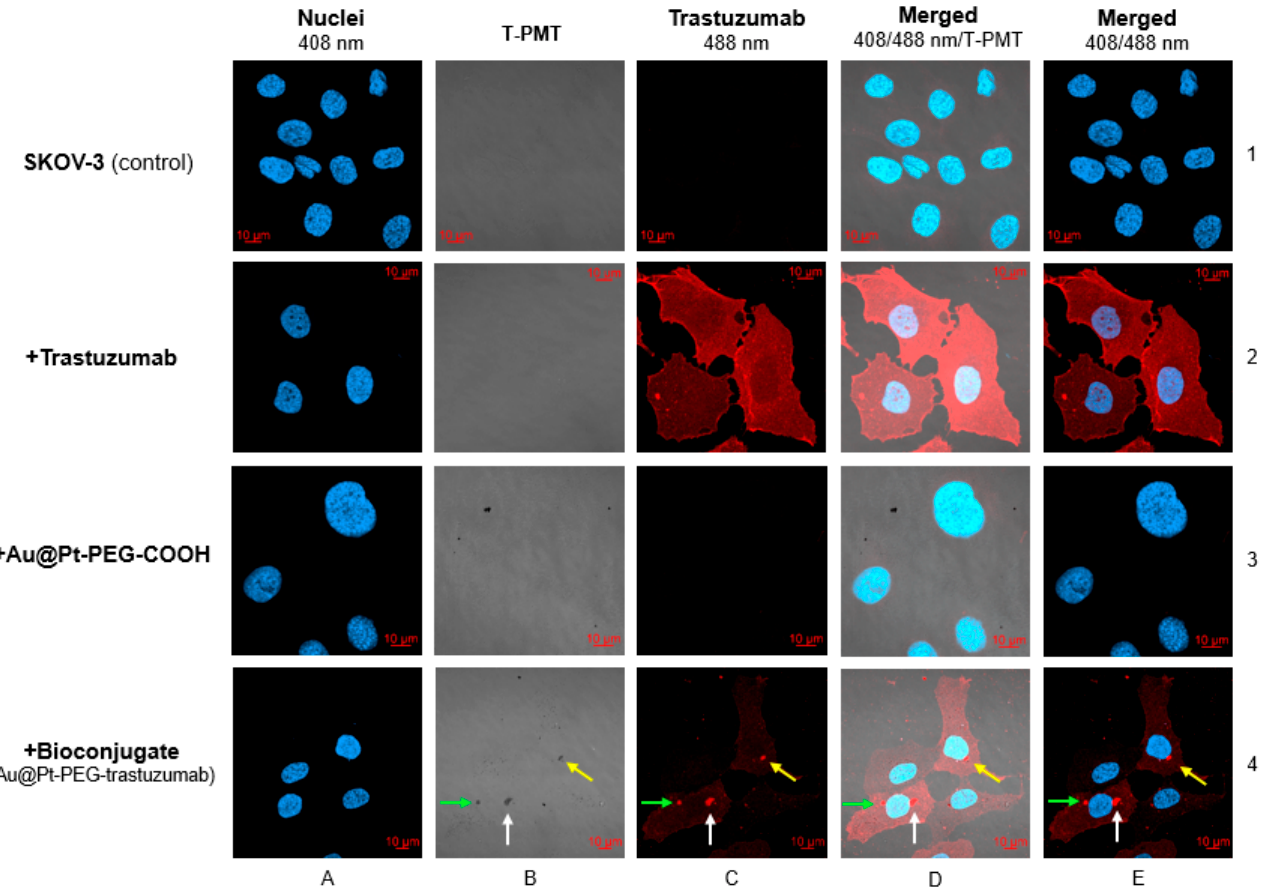
Figure 10. Confocal images of SKOV-3 cells treated with trastuzumab, Au@Pt-PEG-COOH and Au@Pt-PEG-trastuzumab conjugates. As a control untreated cells were used. Blue fluorescence signal–DAPI staining of cell nucleus; red fluores- cence signal–trastuzumab accumulation; black spots–nanoparticles visualized using transmitted light detector (T-PMT). Corresponding signals are marked with colored